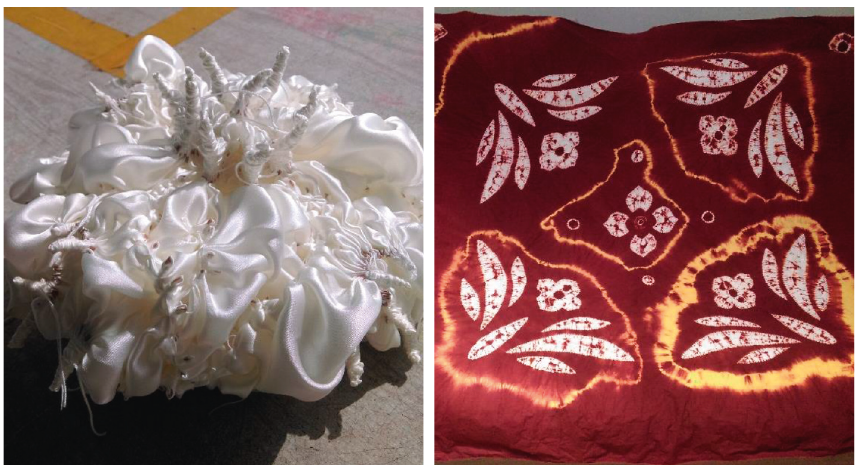
Figure 1: The production process of traditional tie-dyeing process.